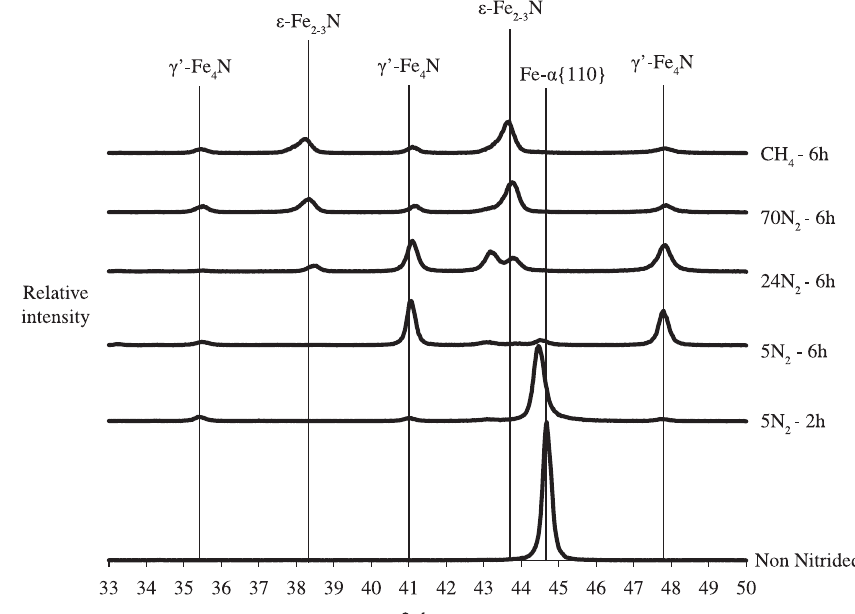
Figure 7. Diffraction lines of non-nitrided and nitrided